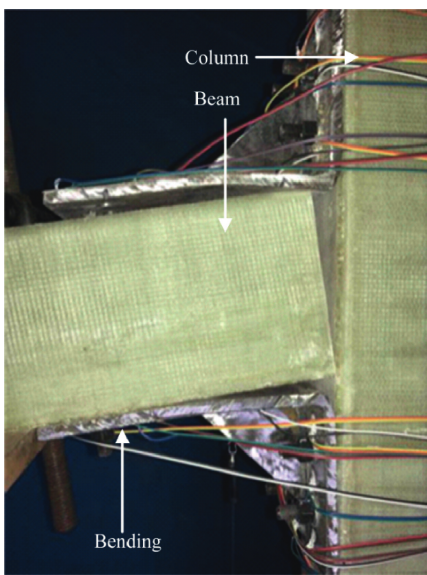
Figure 9: Bolt break failure (TJ-210-R).